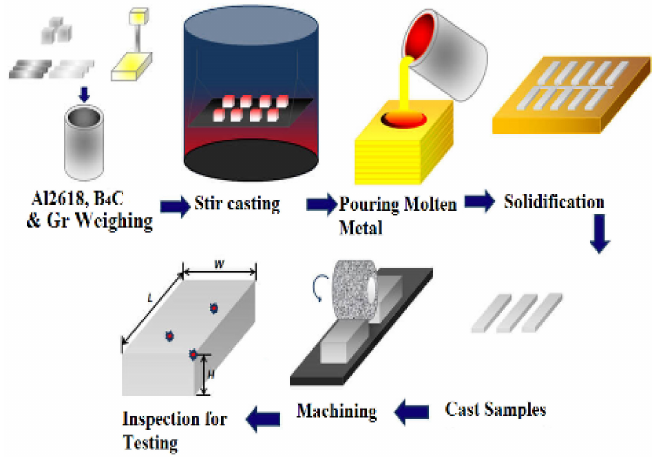
Figure 9. Stir casting